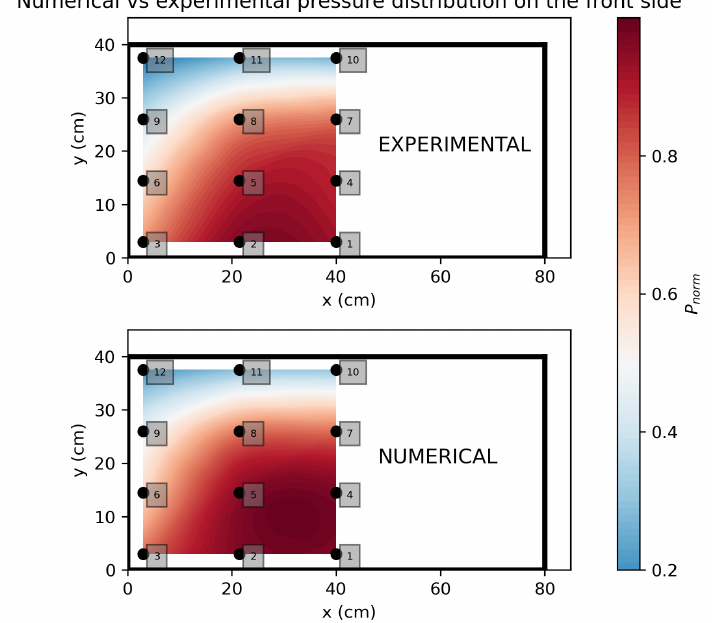
Figure 13. Numerical and experimental pressure distribution on the front side of the panel: 10 m/s